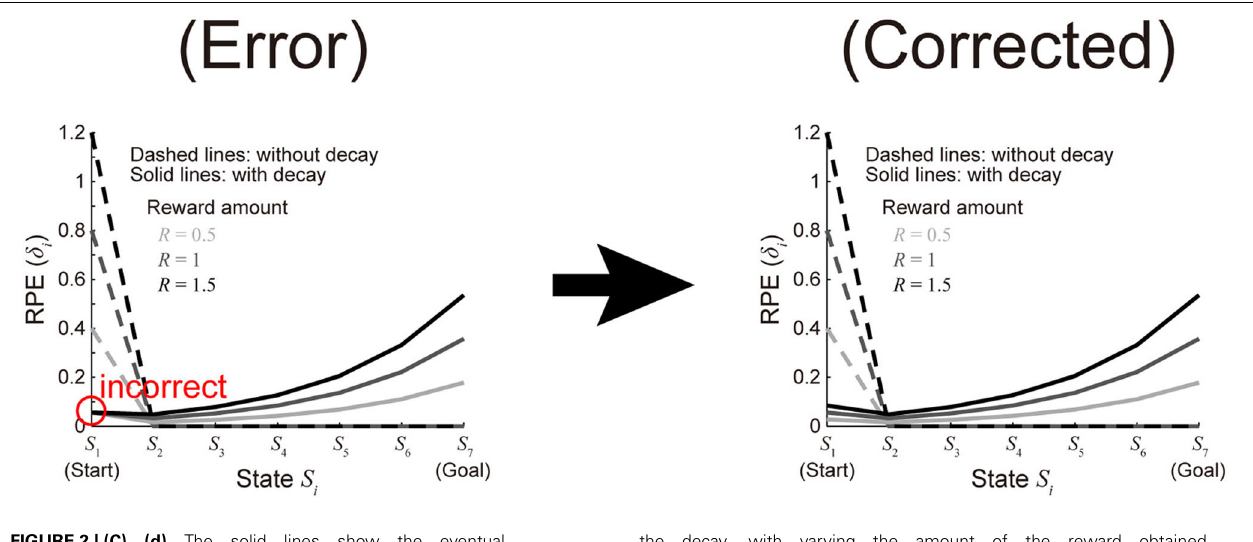
the decay, with varying the amount of the reward obtained at the goal ( R ) (unvaried parameters were set as follows: a = 0 . 6 , y = 0 . 8 (1 / 6) , and x = 0 . 75). The dashed lines show the cases of the model without decay.